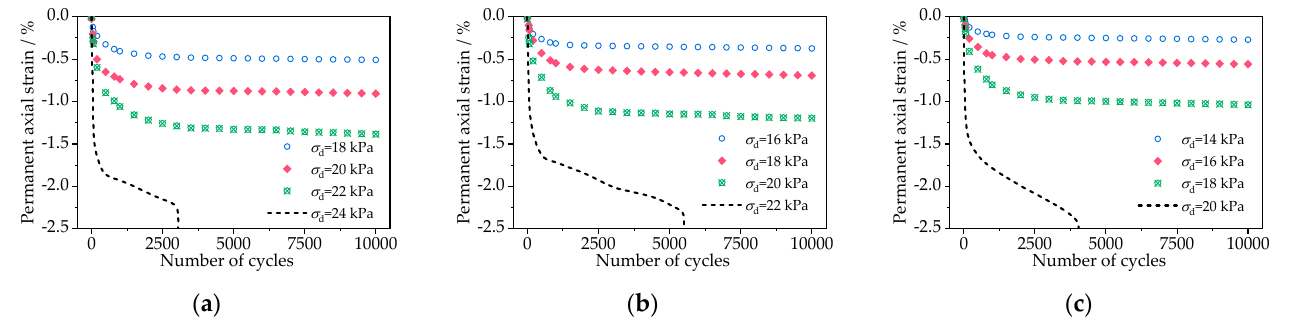
Figure 9. Permanent axial strain under unloading stress path. ( a ) BU − 1 (unloading intensity = 10 kPa); ( b ) BU − 2 (unloading intensity = 20 kPa); ( c ) BU − 3 (unloading intensity = 40 kPa).